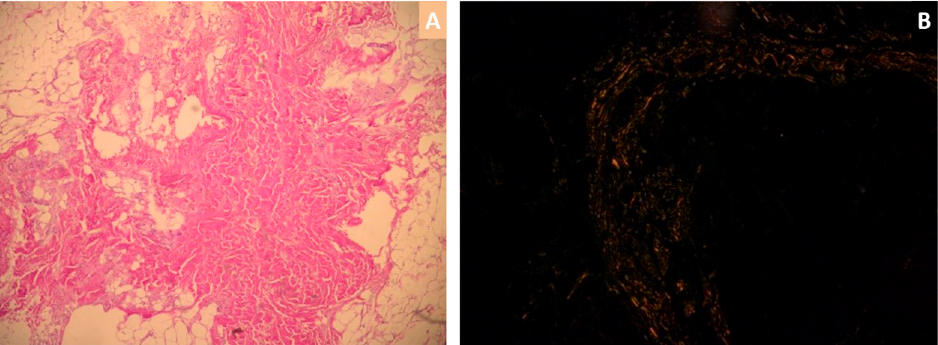
Figure 3. Abdominal fat pad biopsy: hematoxylin and eosin-stained biopsy sections revealing eosinophilic amorphous amyloid fibrils ( A ) and extracellular amyloid deposits with typical apple-green birefringence with Congo red dye under polarized light microscopy ( B ).